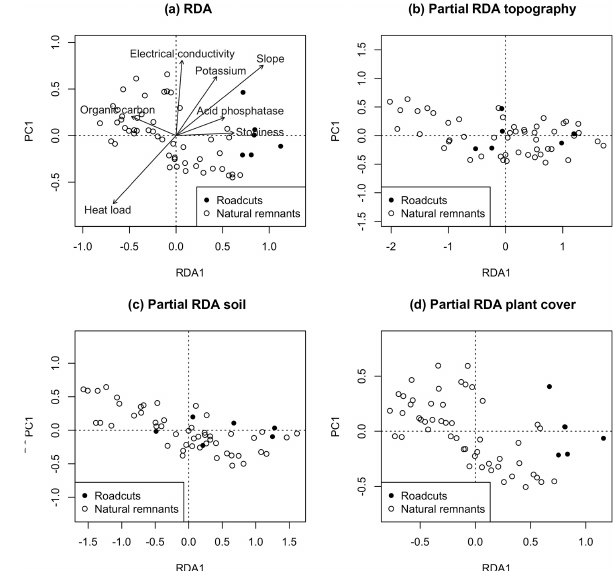
Figure 4. (a) RDA using the type of scenario as the constraining variable. (b, c, d) Partial RDAs using the type of scenario as the constraining variable, in which the variation attributable to (b) to- pography, (c) soil and (d) plant cover was removed before adjusting the model. RDA ordination plots are based on the first and only RDA axis (RDA1) and the following most explanatory PCA axis (PCA1). Variables that significantly adjust to the RDA ( p < 0 . 05) are represented by